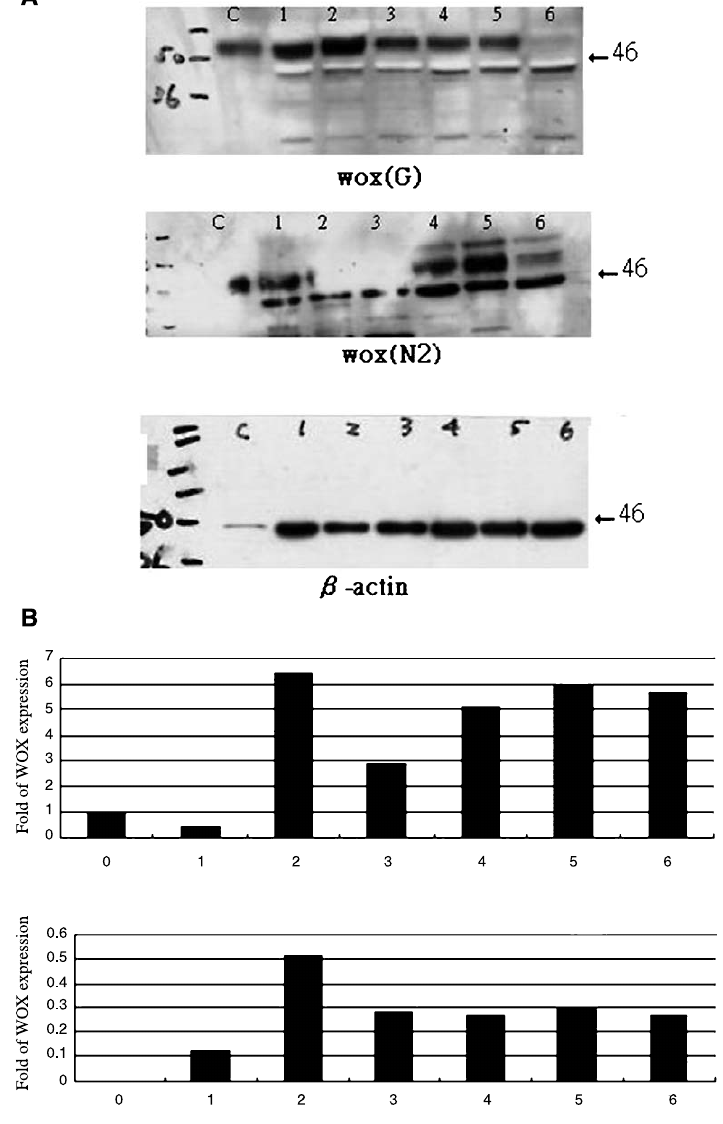
Fig. 8. Western blotting assay indicated WOX1 expression in different meniomas using different antibodies, wox (N2) obtained from Oncogene and wox (G) from Santa Cruz. c, control; 1, atypical type; 2, microcystic type; 3–6, transition types.